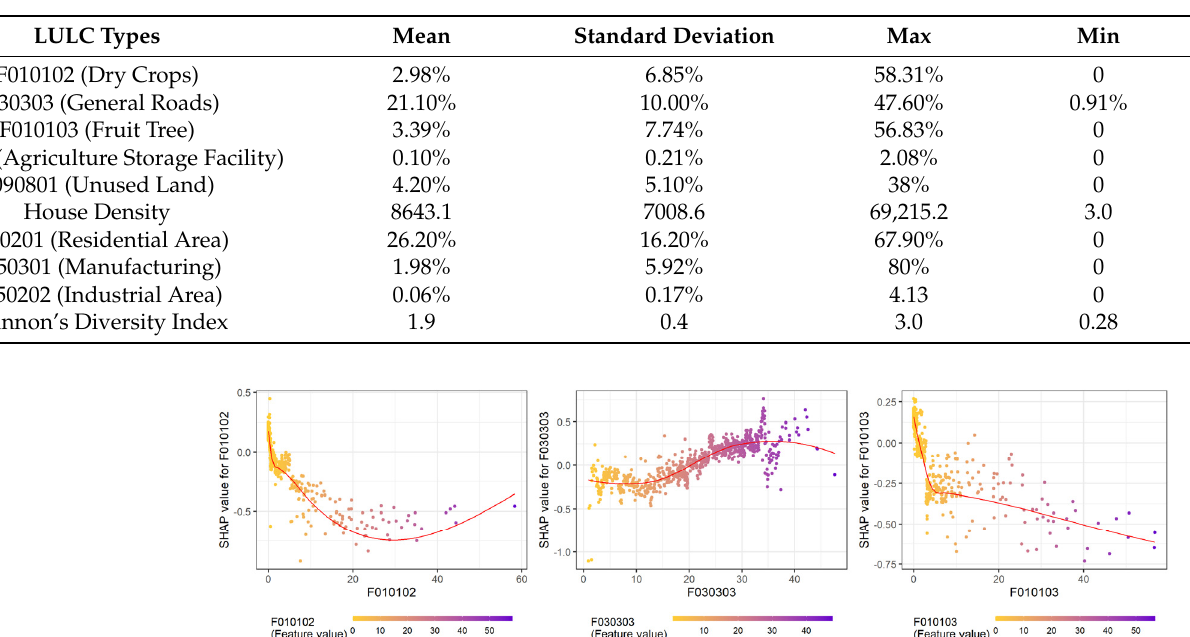
Table 1. Descriptive statistics of the ten most influential land-use land-cover types from the SHAP summary.